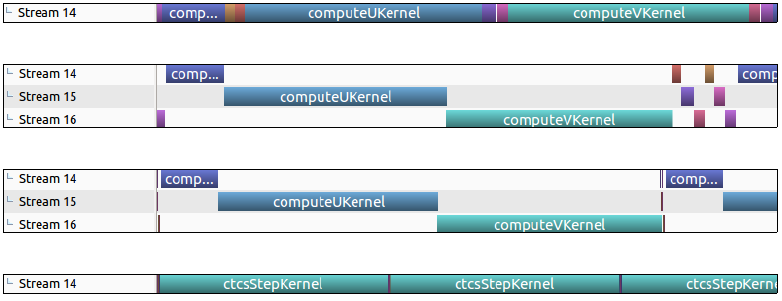
Figure 5. Four screenshots from the Nvidia Visual Profiler, illustrating the effect of optimizations